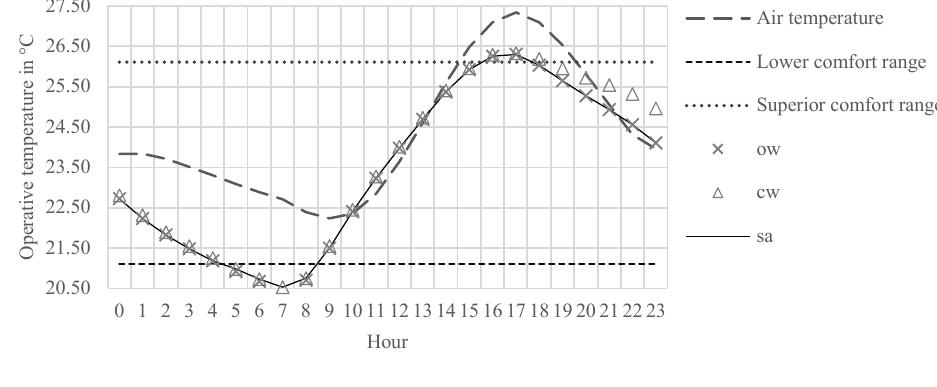
Fig. 11. Operative temperature on October